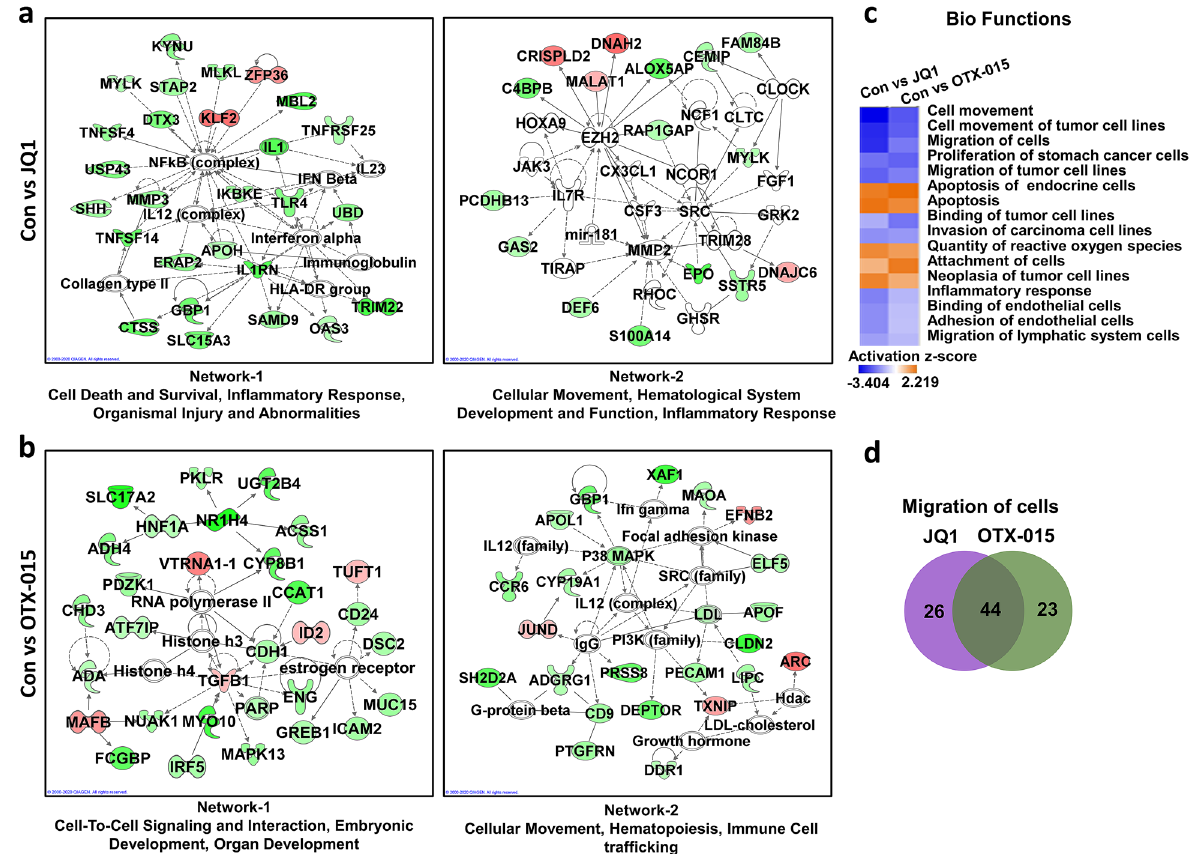
Figure 3. IPA-based network analysis of JQ1- or OTX-015-treated HCC cells. ( a ) Gene networks of JQ1- or ( b ) OTX-015-treated HCC cells by IPA. ( c ) Biofunctional analysis of alternated gene datasets in Con vs. JQ1-treated HCC and Con vs. OTX-015-treated HCC cells using IPA. ( d ) The area of overlap indicates the number of shared genes that related with migration of cells in JQ1 and OTX-015 treated